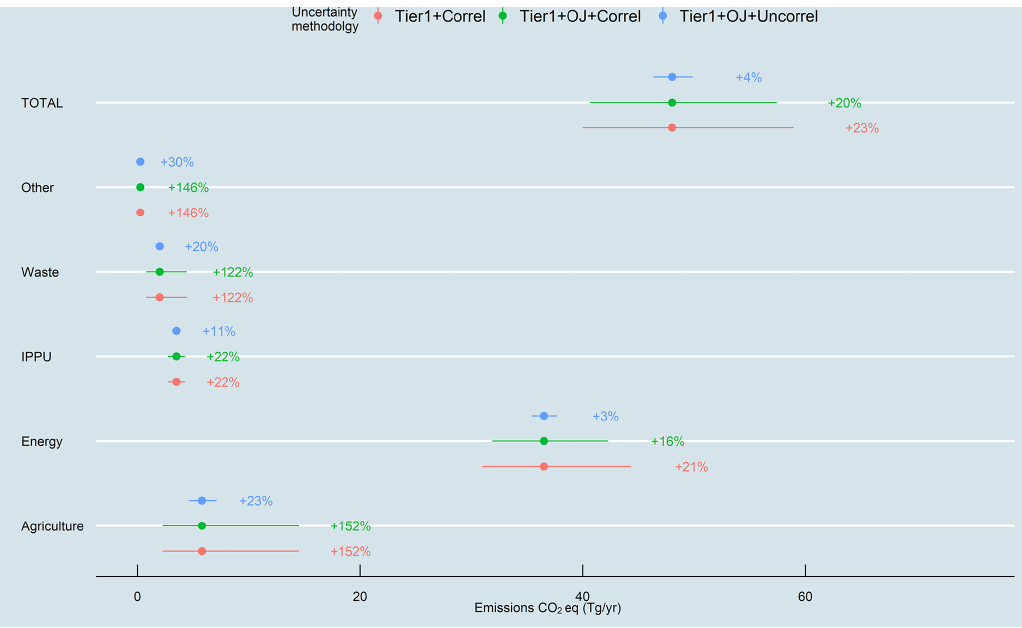
Figure 13. Variability in the world emission uncertainty introduced by methodological choices. “Tier 1 + Correl” (in red) is the base case and assumes correlation among subsectors and among sectors across countries and default Tier 1 IPCC-06 uncertainty; “Tier1 + OJ + Correl” (in green) only differs from the base case for the N 2 O uncertainty in sector 1.A ( ± 100% to ± 150%) (green); Tier1 + OJ + Uncorrel (in blue) differs from the base case as it assumes no correlation as well as N 2 O uncertainty in sector 1.A in the range from ± 100% to ±